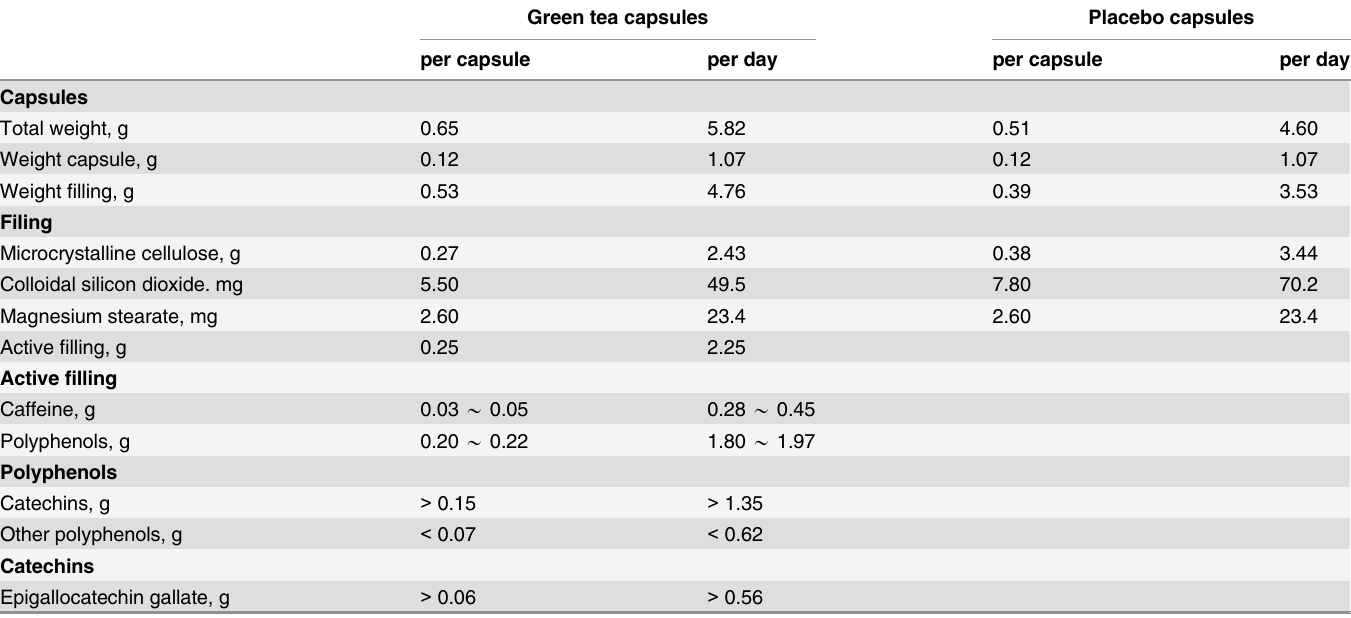
Table 1. Composition of the green tea extract and placebo capsules and total dose consumed per